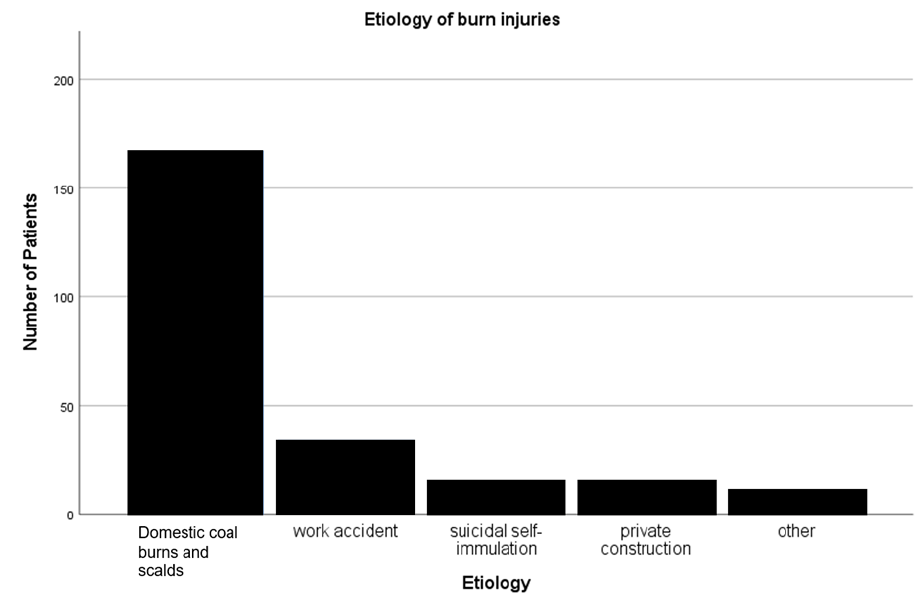
Figure 1. Aetiology of burn injuries.